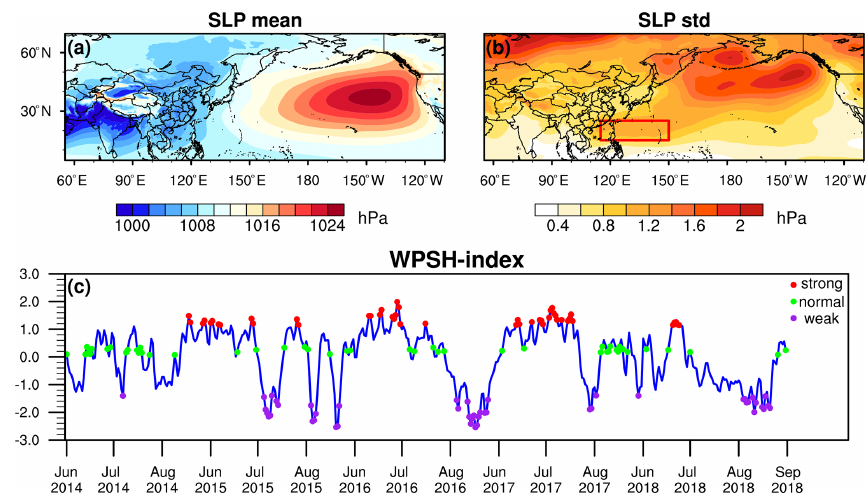
Figure 1. Western Pacific mean sea level pressure (a) and its standard deviation (b) calculated using June, July, and August (JJA) data from 1979 to 2018. Red box in (b) indicates the region (15–25 ◦ N, 115–150 ◦ E) used to calculate the WPSH index. Panel (c) Shows the time series of WPSH index and the selections of three types of WPSH. The blue line represents the normalized WPSH index of 460d in JJA from 2014 to 2018. Red dots represent strong WPSH days, green dots represent normal WPSH days, and purple dots represent weak WPSH